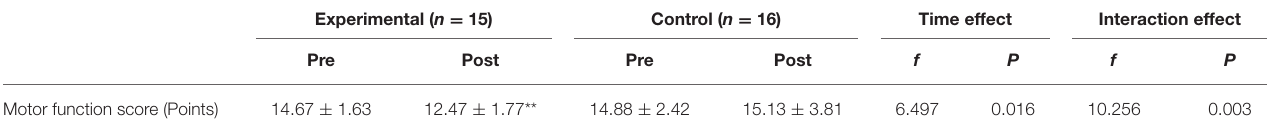
TABLE 5 | Unified Parkinson’s Comprehensive Rating Scale III (functional assessment) before and after 12 weeks of